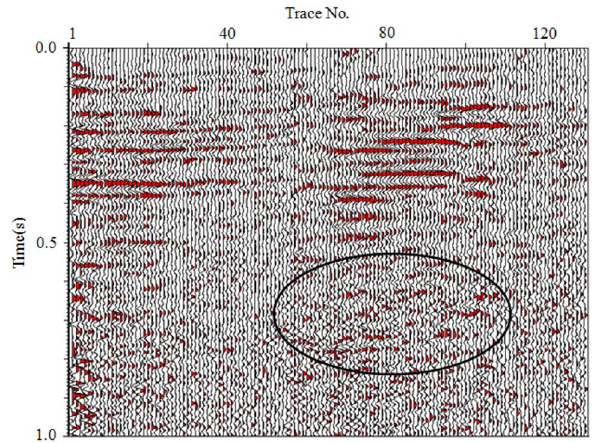
Fig. 9 Reflection signals separated from Fig. 4 using SVD filtering method. The first 15 singular values are used. The weak reflection can be recognized more clearly, and it is convenient to interpret